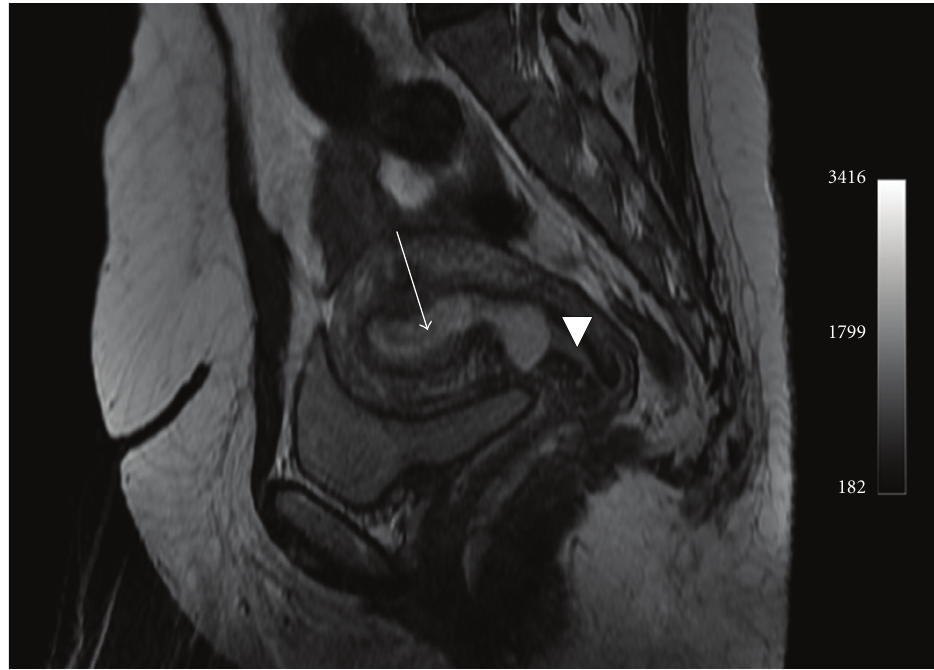
Figure 4: Magnetic resonance imaging cesarean scar pregnancy, empty uterus (arrow), empty cervical canal (arrow